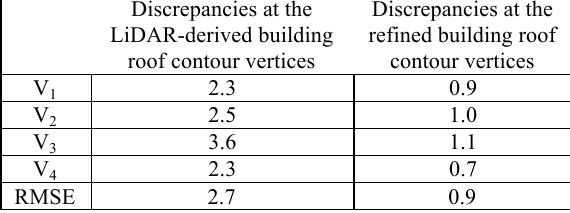
Table 2 - Discrepancies (in meter) between the LiDAR-derived and reference building roof contours and between the refined and reference building roof contours – Example